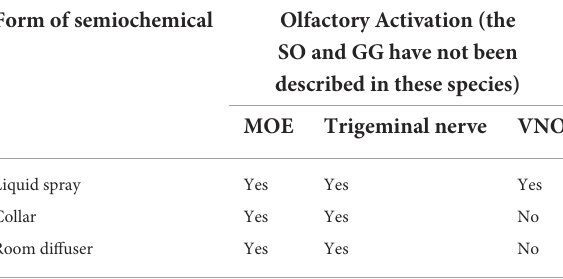
TABLE 1 Physical form of semiochemicals that may activate three major olfactory sensory organs. Form of semiochemical Olfactory Activation (the SO and GG have not been described in these species) MOE Trigeminal nerve VNO Liquid spray